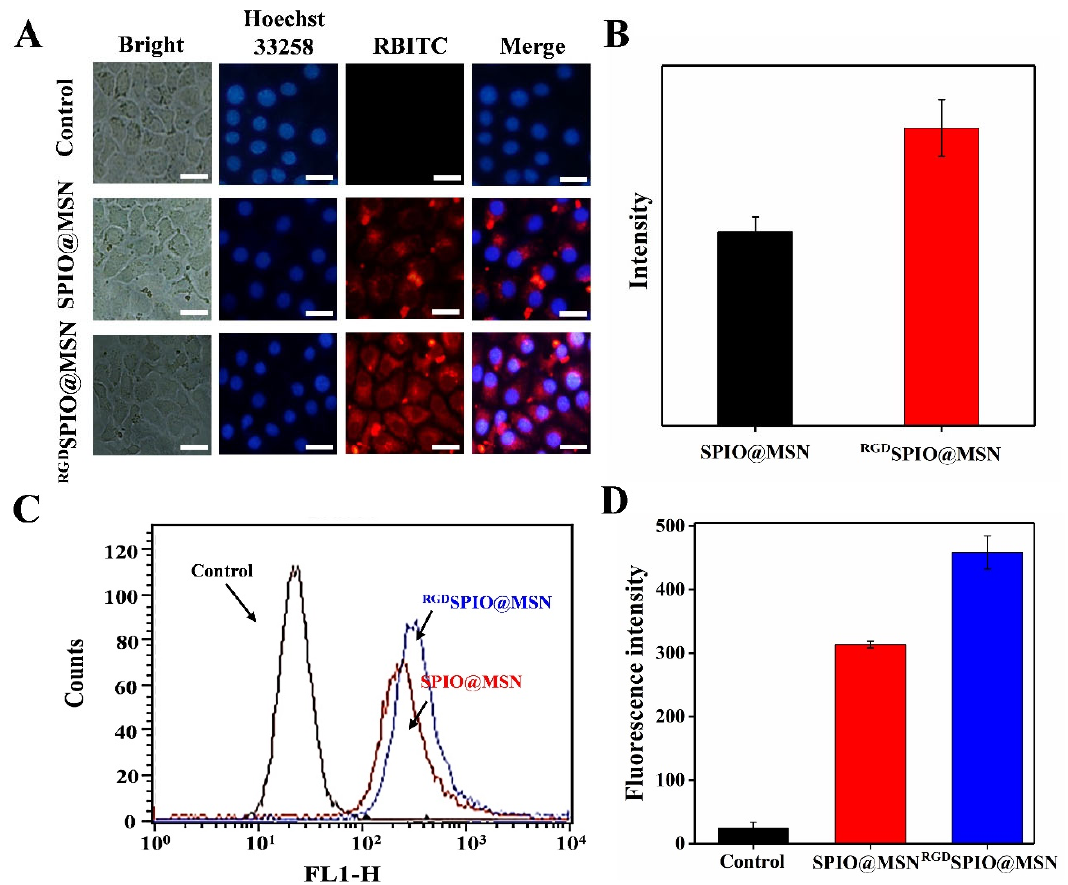
Figure 4. ( A ) Fluorescence images of HepG2 cells treated with RBITC ‐ labeled SPIO@MSN NPs and RGD SPIO@MSN NPs for 24 h, with cell nuclei stained with Hoechst 33258, and ( B ) the corresponding quantitative analysis, scalebar = 20 μ m. ( C ) Assay of cellular uptake after 4 h treatment with various RBITC ‐ labeled nanocarriers by flow cytometry, and ( D ) the corresponding quantitative analysis.